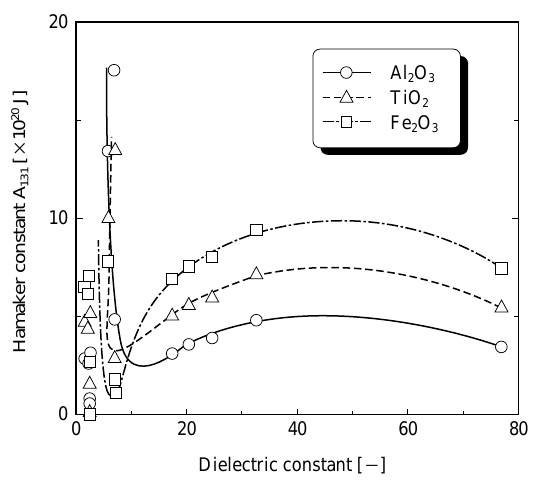
Relationship between Hamaker constant and dielectric constant of various